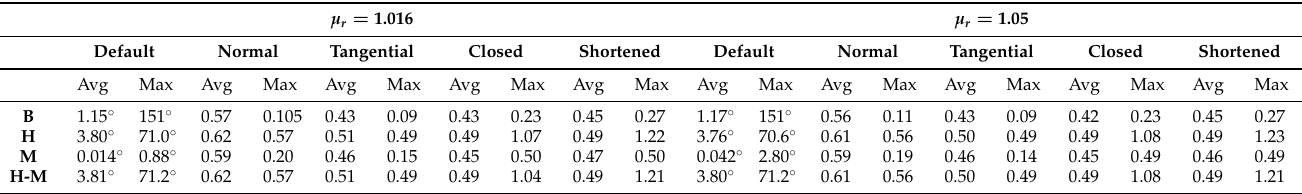
Table 9. No-load angular dependency for B , M and H for different relative permeability values for the rotating machine. For the design alterations, the inclination angles are given as a fraction of the respective inclination angle for the default case. The pole shoe alterations are illustrated in Figure